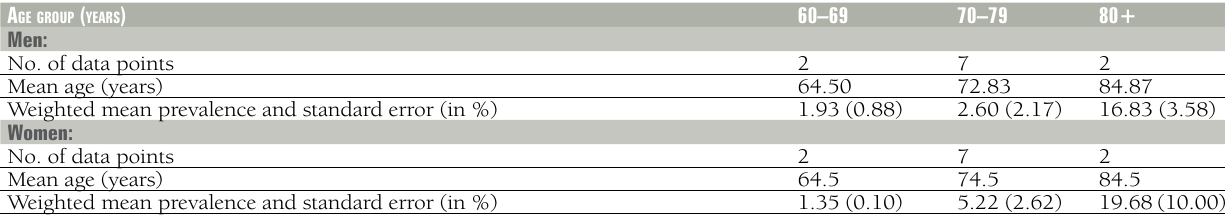
Table 7 A comparison of age–specific weighted mean prevalence of dementia in African men and women a ge group ( years )